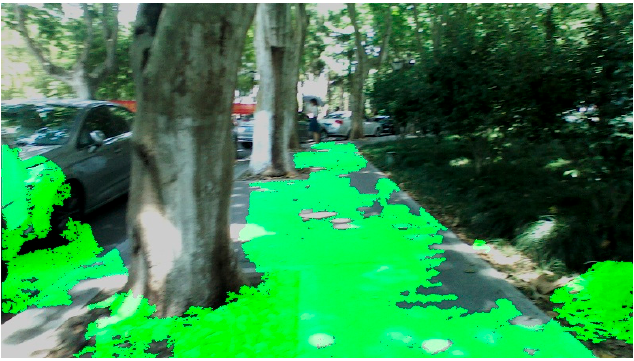
Figure 11. An example of expansion error. The ground has been unexpectedly expanded to a part of the car. The approach creates a multithreaded program including a thread for image acquisition and depth enhancement, a thread for traversable area detection and expansion, as well as a thread for audio interface generation for the VIP. Together, the average processing time of a single frame is 610 ms on a 1.90 GHz Intel Core 5 processor, making the refresh rate of the VIP audio feedback 1.6 times per second. In addition, detection rate and expansion error for indoor and outdoor scenarios are